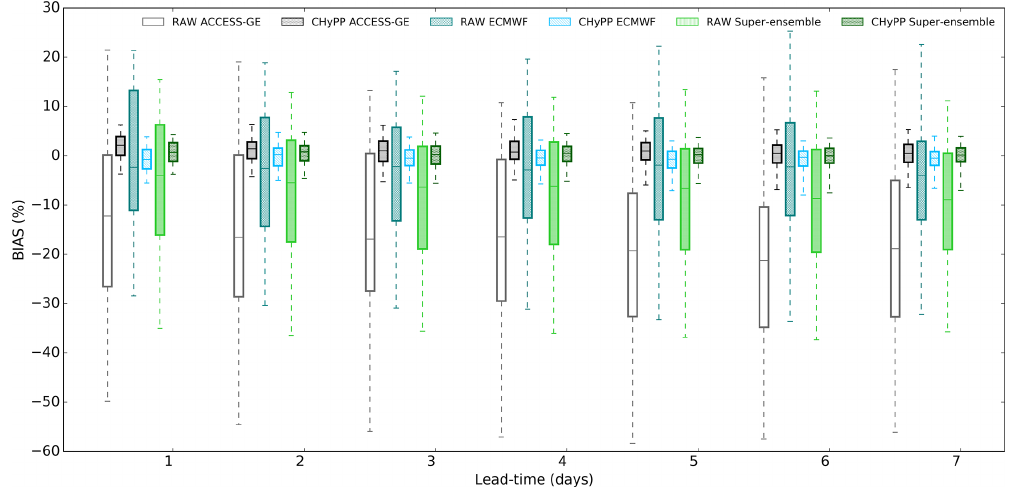
Figure 4. Bias (%) of raw and calibrated (using CHyPP) forecast rainfall products, ACCESS–GE2, ECMWF, and the super-ensemble for the 100